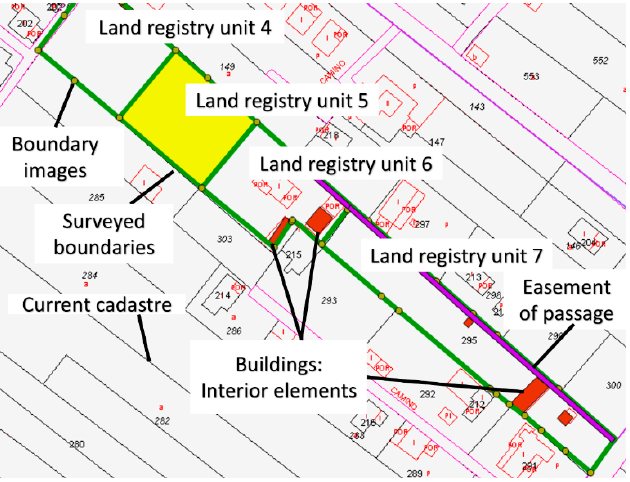
were taken. were taken.